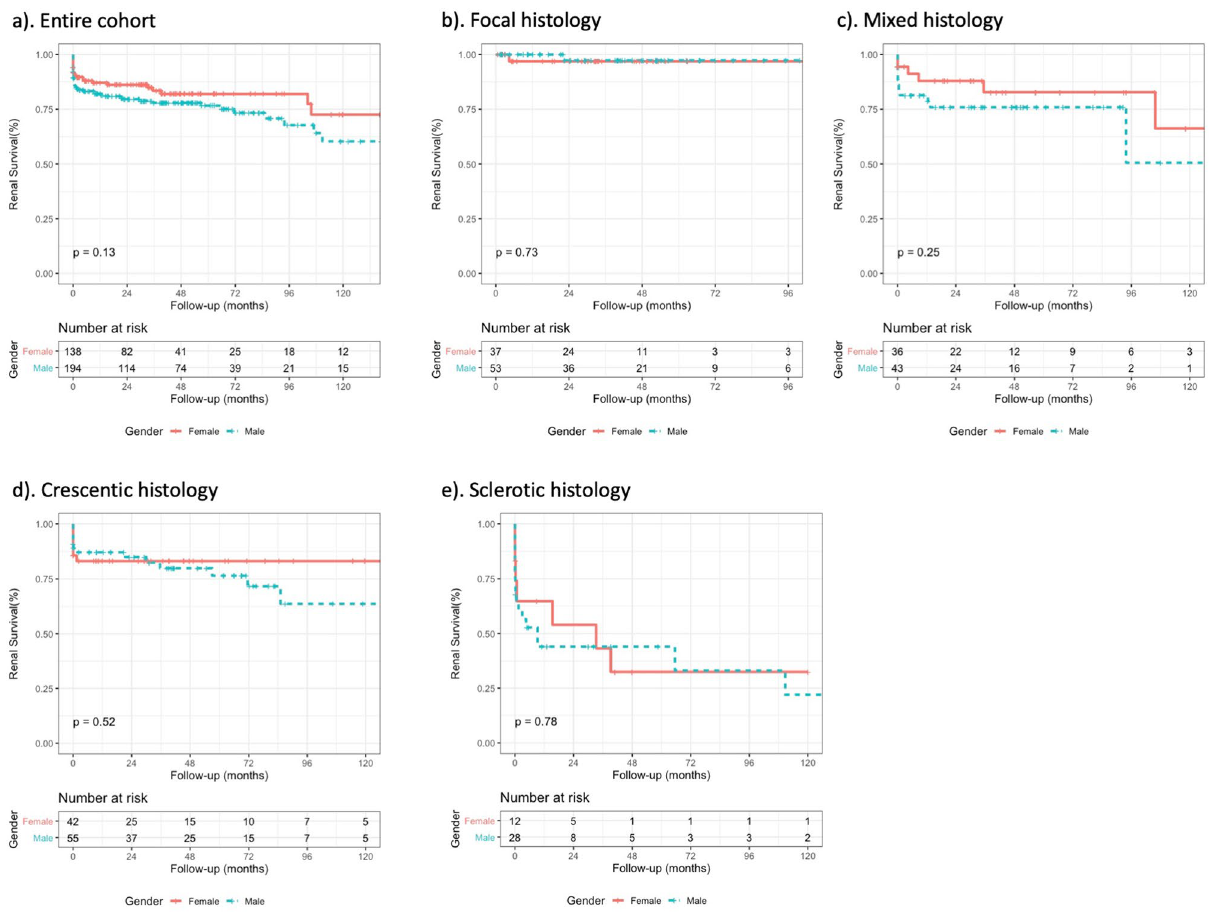
Figure 1. Kaplan–Meier plots demonstrating renal survival in males versus females in ( a ) the entire cohort, and in those with ( b ) focal histology, ( c ) mixed histology, ( d ) crescentic histology and ( e ) sclerotic histology.